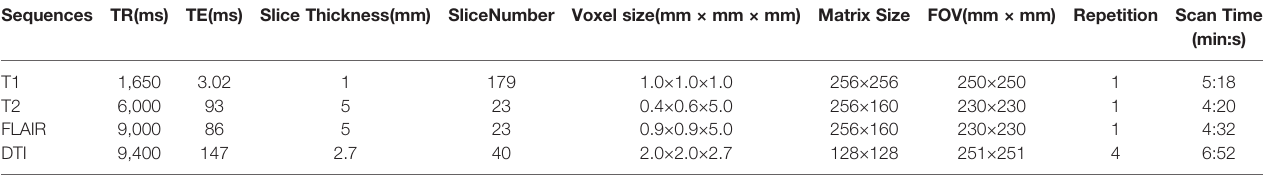
TABLE 1 | MRI sequences and parameters.